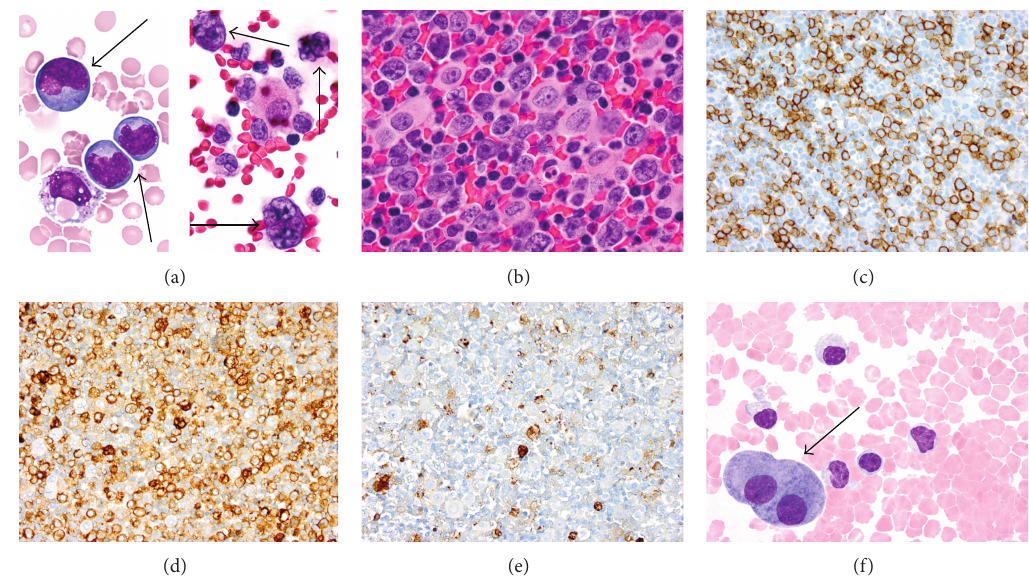
F 2: Examination of the initial thoracentesis �uid demonstrated scattered large atypical lymphoid cells with multilobated nuclei, vesicular chromatin and multiple prominent nucleoli (arrows), in a background of benign mesothelial cells, histiocytes, small lymphocytes and neutrophils ((a), le, May-Grünwald-Giemsa, and right, hematoxylin and eosin). e corresponding cell block specimen showed similar �ndings (hematoxylin and eosin). Immunohistochemical stains showed the scattered large cells to be positive for CD20 (c) and kappa light chain-restricted (d), with few lambda-positive cells in the background (e). A repeat thoracentesis specimen taken 1 month later showed no evidence of malignancy, with only benign mesothelial cells (arrow) and hematopoietic elements (Wright-Giemsa).